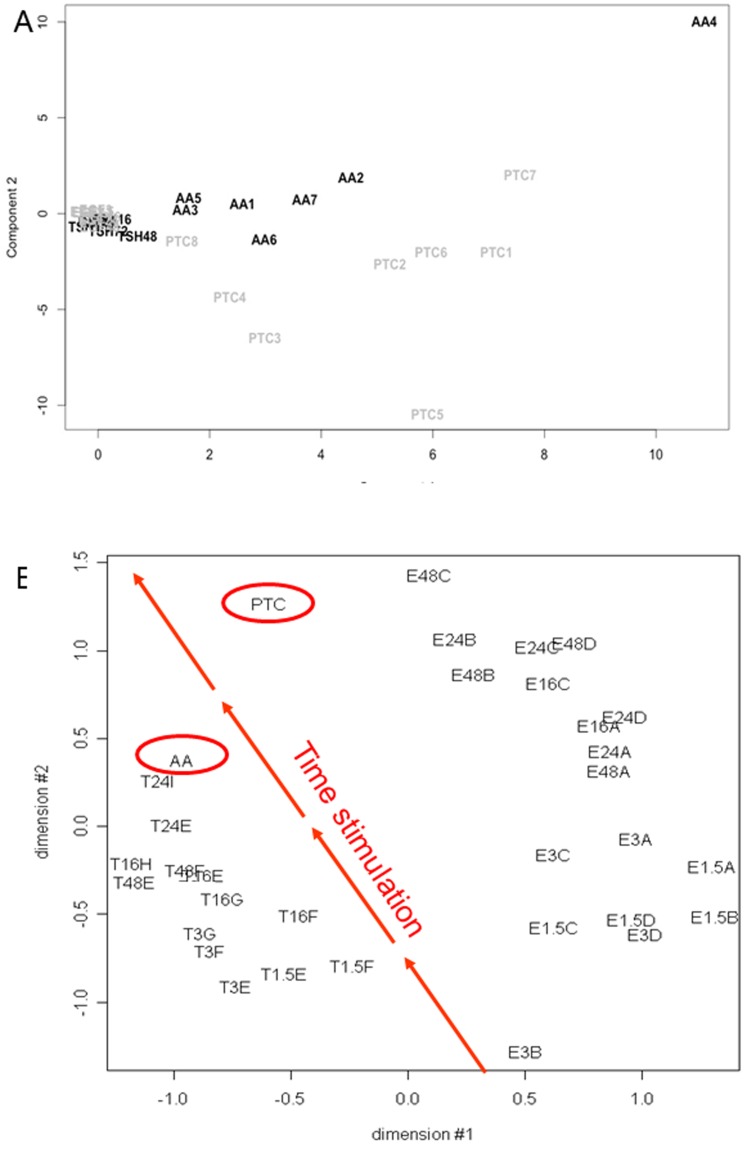
A: Principal Component Analysis of the miRNA expression data from primary cultures stimulated for 1,5, 3, 16, 24 and 48 hours with TSH or with EGF/serum and from tumor tissues (autonomous adenomas (AA) and papillary thyroid carcinomas (PTC)).The two main components are shown. All the treated primary cultured samples are localized close to each other near the origins of the axis, illustrating the low change on the miRNA expression resulting from the treatment. The proportion of variance explained by the Principal Component 1 and 2 are 0.353 and 0.270, respectively. The PCA was generated with R 2.8.1 with the function Prcomp. B: Multi-dimensional scaling analysis (MDS) based on four independent human primary thyroid cell cultures stimulated with 25 ng/ml EGF and 10% serum (E) for 1.5, 3, 16, 24 and 48 hours and on five independent human primary thyroid cultures stimulated with 0.3 mU/ml TSH (T) for similar times [32]
. Expression profiles from a pool of autonomous adenomas (AA) and of a group of papillary thyroid carcinomas (PTC) were included. The MDS is based on all the spots present on the array. The distortion of distances (stress) between the MDS 2D space and the actual gene space is 19.6%.